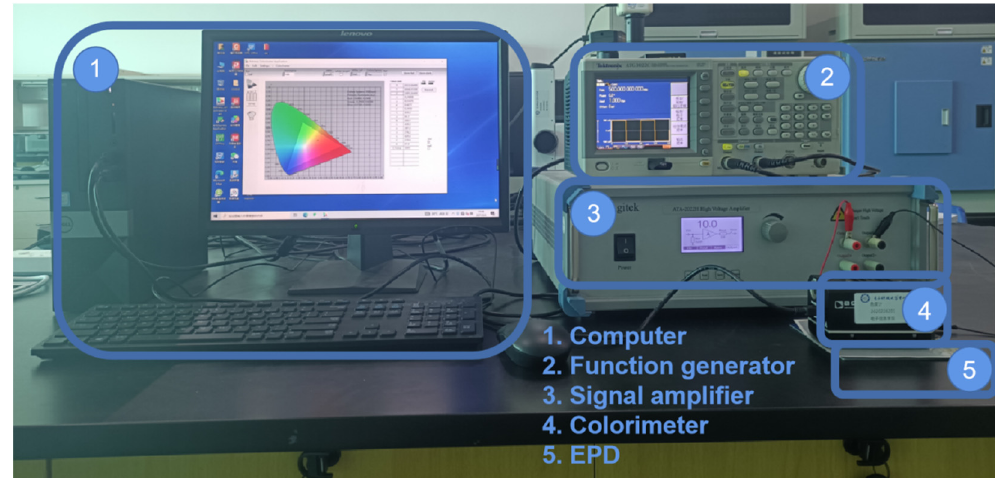
Figure 2. Experimental platform for the testing of EPD color gamut, luminance and response time. It was composed of a driving system and a testing system. ( 1 ) computer. ( 2 ) function generator. ( 3 ) signal amplifier. ( 4 ) colorimeter. ( 5 ) EPD.